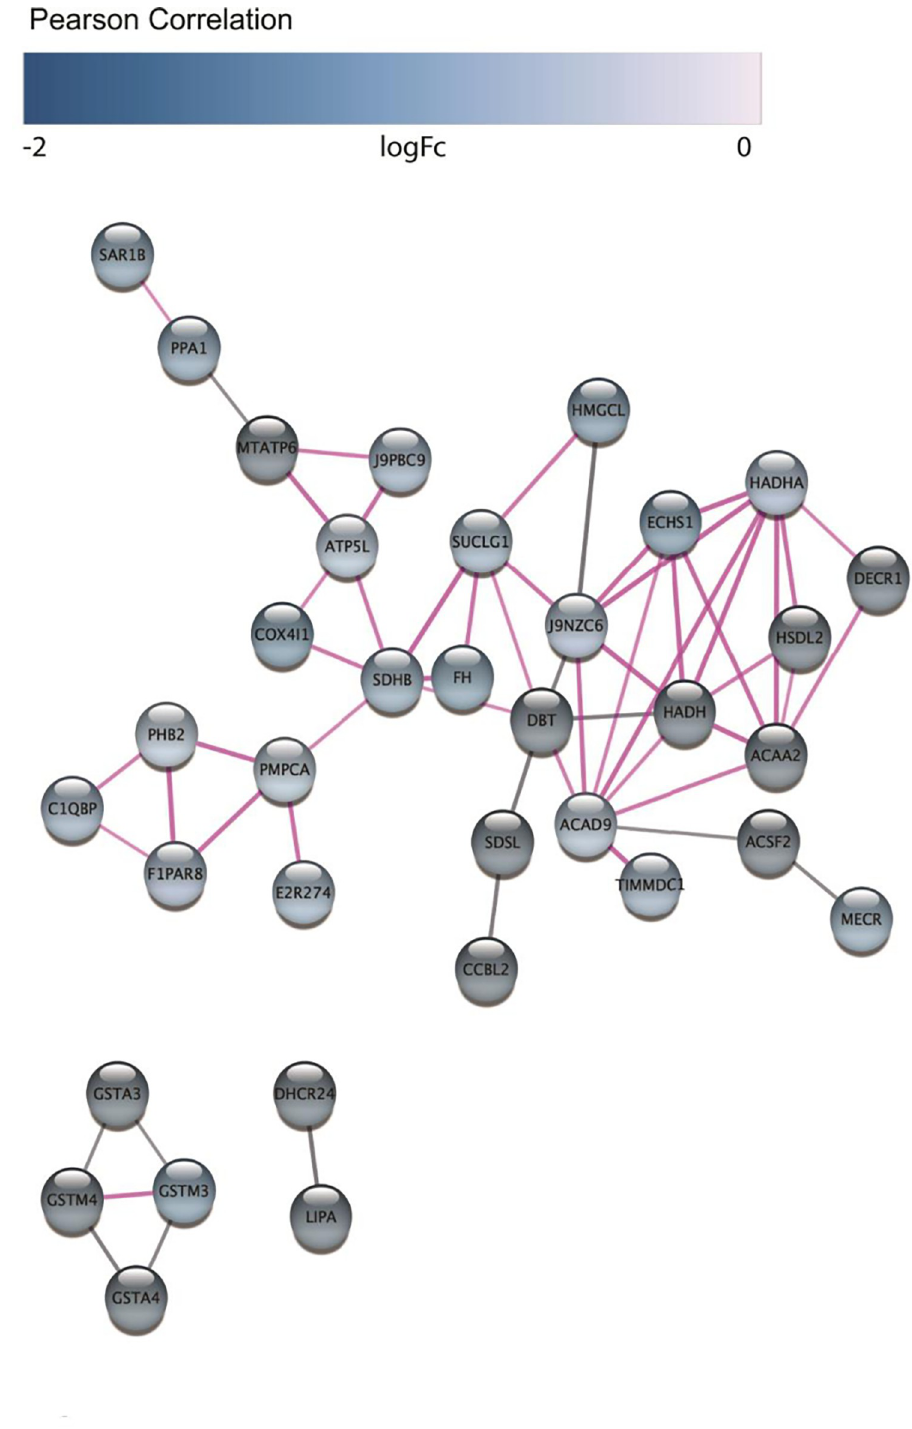
Fig 6. STRING network of differentially expressed downregulated proteins canine hepatobiliary NEN. Log-ratios of protein abundance between cancer and normal tissues were mapped using a white-purple gradient. STRING network confidence cutoff is 0.7. Nodes connected by pink edges have interactions that have been experimentally validated. Image generated in Cytoscape StringApp.